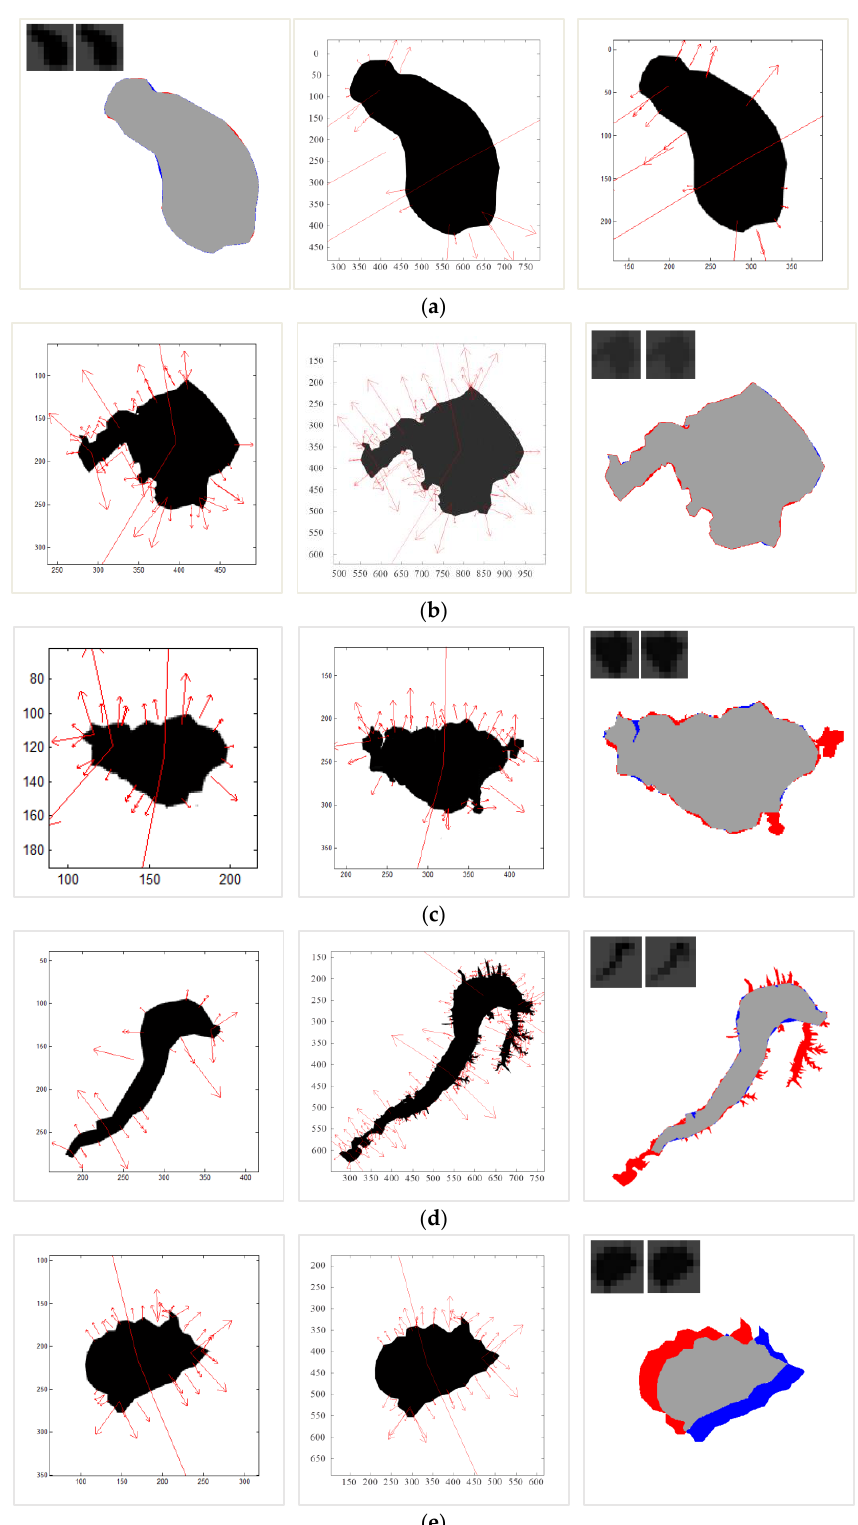
Figure 8. Typical examples of consistency divisions. ( a ) GC = 1, LC = 0.53, OD = 0.99, and C = 0.86. Grade: highly consistent; ( b ) GC = 1, LC = 0.50, OD = 0.99, and C = 0.85. Grade: highly consistent; ( c ) GC = 0.9, LC = 0.34, OD = 0.96, and C = 0.74. Grade: less consistent; ( d ) GC = 0.4, LC = 0.33, OD = 0.85, and C = 0.42. Grade: inconsistent; ( e ) GC = 1, LC = 0.68, OD = 0.75, and C = 0.88. Grade: highly